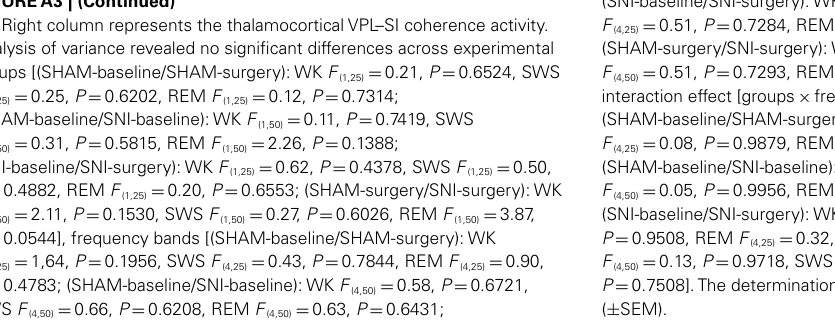
FIGUREA3 | (Continued) (B) Right column represents the thalamocorticalVPL–SI coherence activity. Analysis of variance revealed no significant differences across experimental groups [(SHAM-baseline/SHAM-surgery):WK F (1,25) = 0.21, P = 0.6524, SWS F (1,25) = 0.25, P = 0.6202, REM F (1,25) = 0.12, P = 0.7314; (SHAM-baseline/SNI-baseline):WK